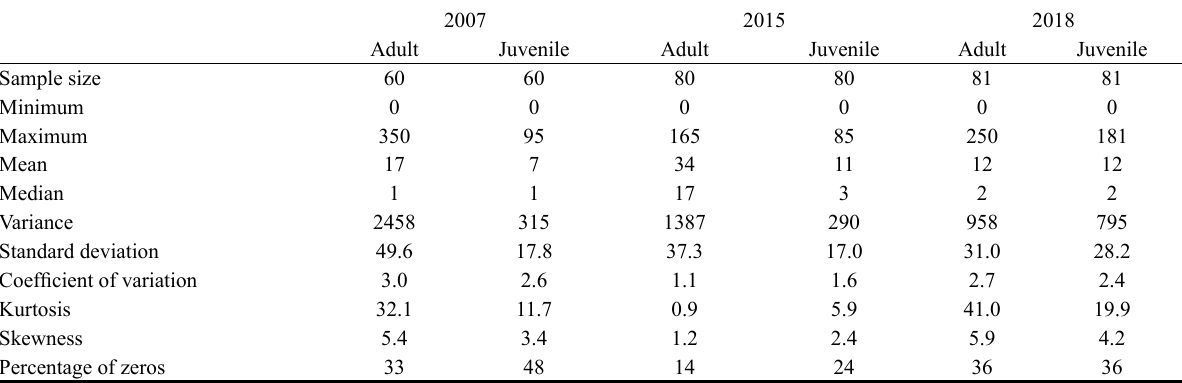
Table 1. – Descriptive statistics of queen conch survey data for the years 2007, 2015 and